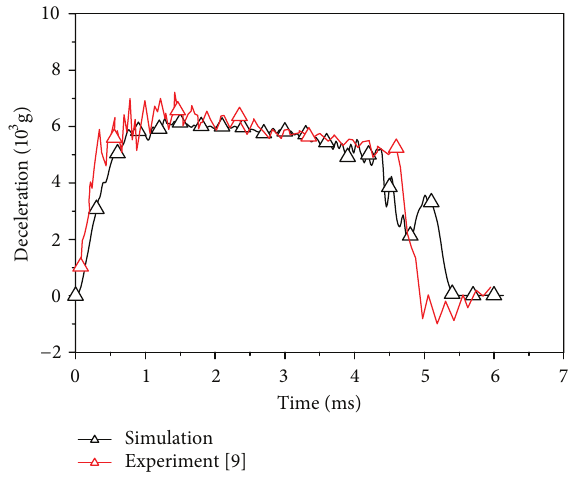
Figure 2: Deceleration versus time.